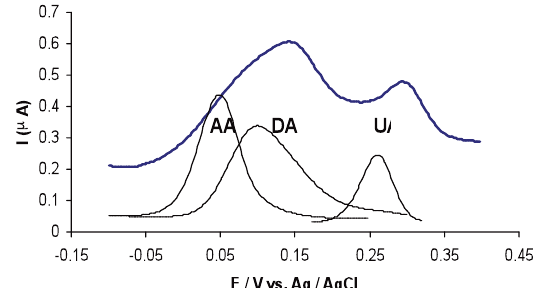
Figure 4. Differential pulse voltammograms of DA (3.5 µM), AA (60 µM) and UA (2 µM) and mixture (7.2 µM DA, 66.5 µM AA and